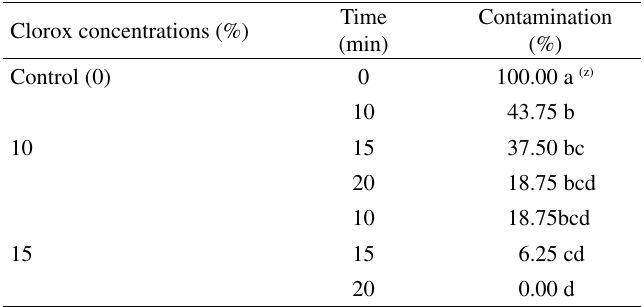
Table 1 - Effect of different concentrations of Clorox on surface steril- ization of explants of Dracaena sanderiana Sander ex Mast. Clorox concentrations